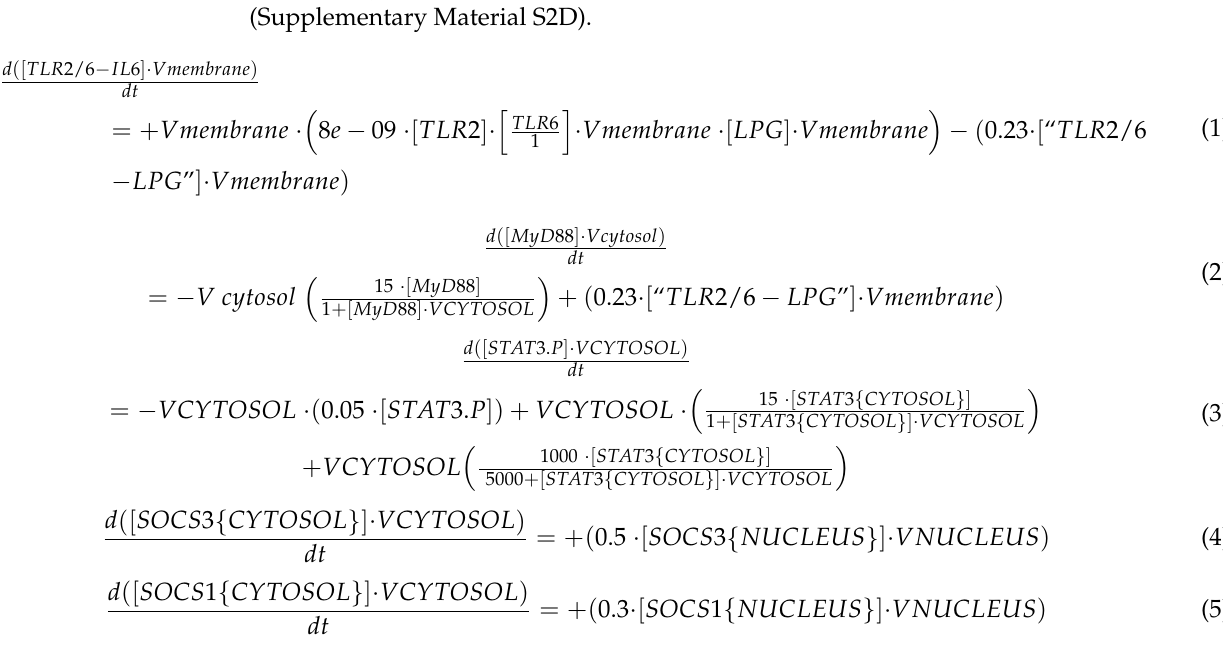
Table 1. Reaction that governs the disease progression at cellular level.